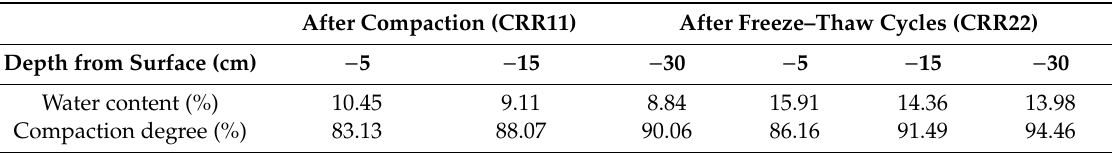
Table 10. The results of plate load test for CRR11 and CRR22.